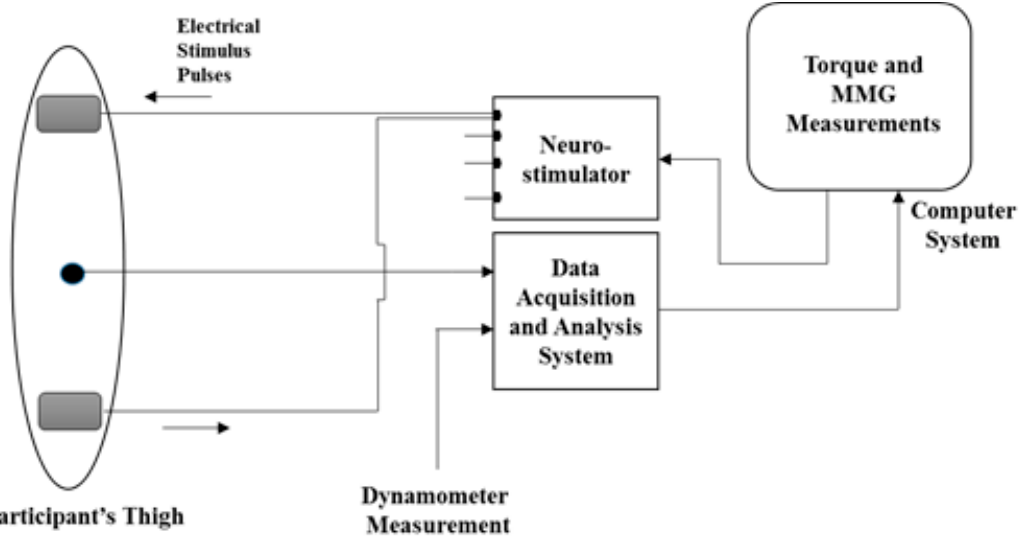
Figure 2. Schematic representation of the experimental setup. Stimulation electrodes ( A ) cathode, ( B ) anode NMES electrodes, and ( C ) MMG sensor.